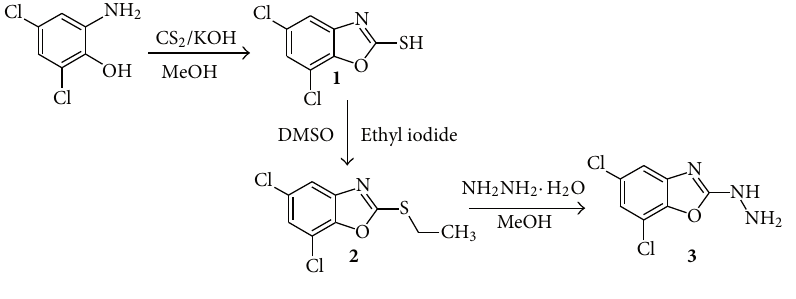
S 1: Synthetic route for compound 3